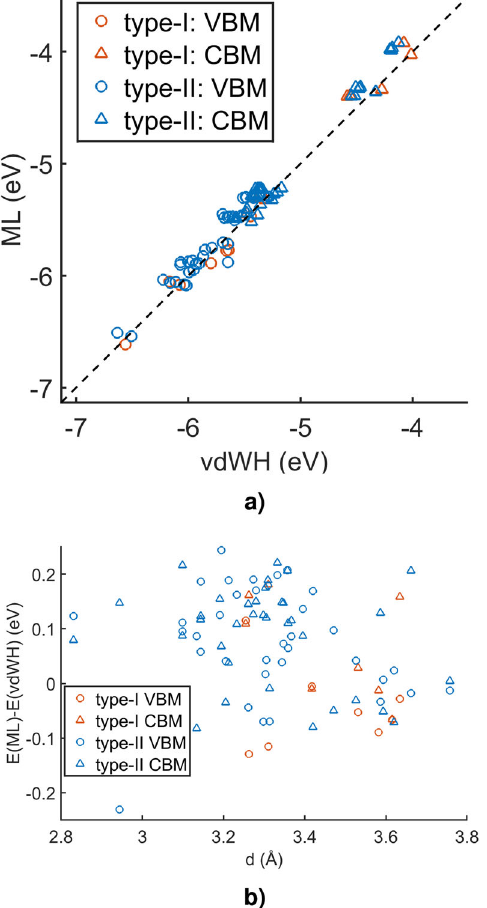
Fig. 4 Band information of the 45 vdWHs investigated. a Band- edge energies of the vdWH against those of the constituent monolayers. b Band-edge deviation against inter-layer distance. Here we have de fi ned Δ E ¼ E α band edge energy for the monolayer (vdWH) and α = VBM and CBM. The different colors identify the band-gap type of the